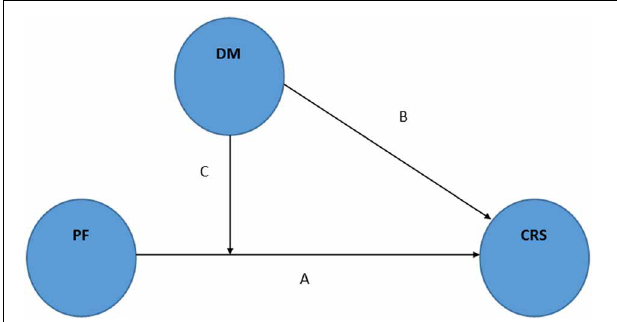
FIGURE 2 | Schematic representation of the moderator hypothesis: mindfulness as moderator of the physical fitness effects on cardiovascular responses to stress. Adapted from Baron and Kenny (1986). PF: physical fitness. DM: dispositional mindfulness. CRS: cardiovascular responses to stress.